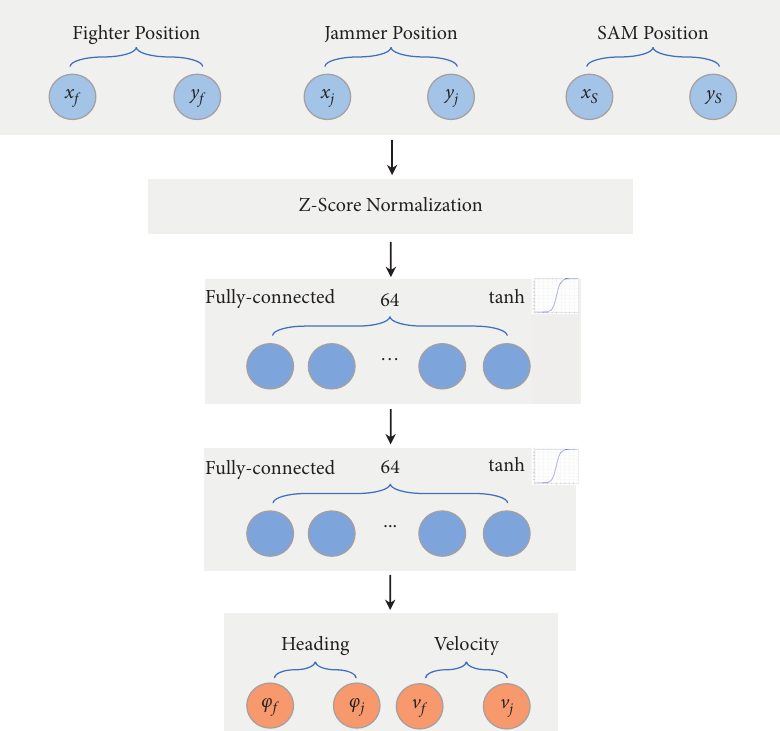
Figure 4: Illustration of observation vector and policy network architecture used in the present work.